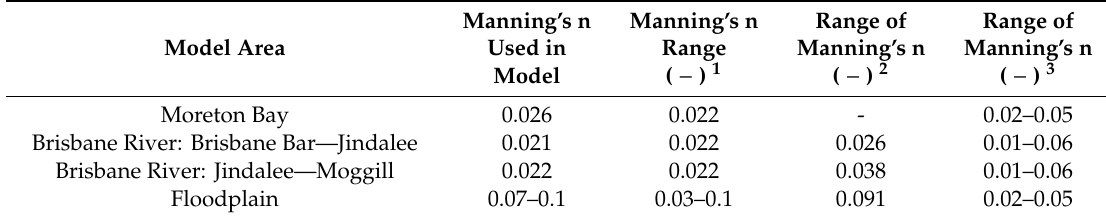
Table 3. Calibrated Manning’s n for the 2013 flood